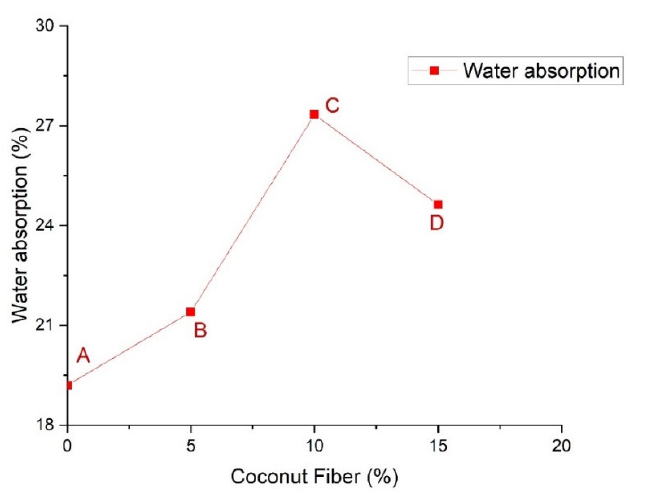
Figure 9. Water absorption (%). Different letters on the line mean that there was a statistically significant difference.